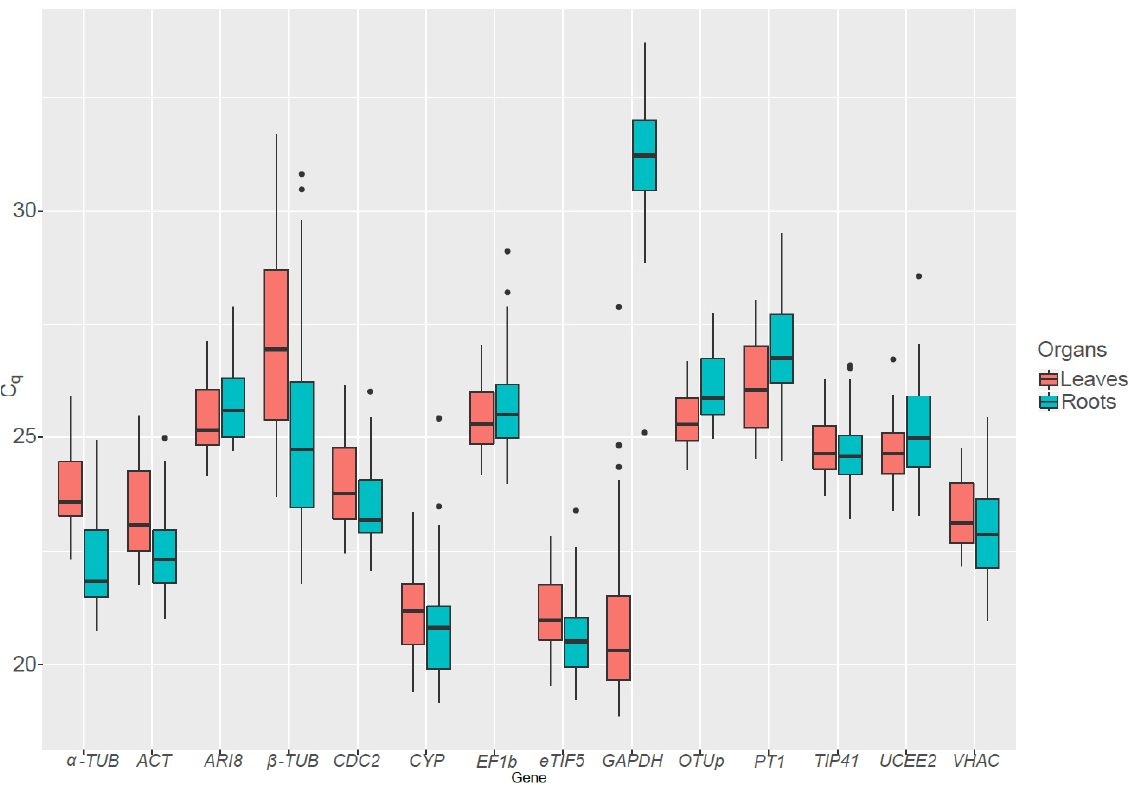
Figure 2. Boxplot of the quantification cycle (C q ) values for 14 candidate reference genes in S. viminalis roots and leaves exposed to various abiotic stresses. Eight-month old cuttings were exposed to drought, cold, heat, metal or salt stress in triplicate for up to two months before being sampled.